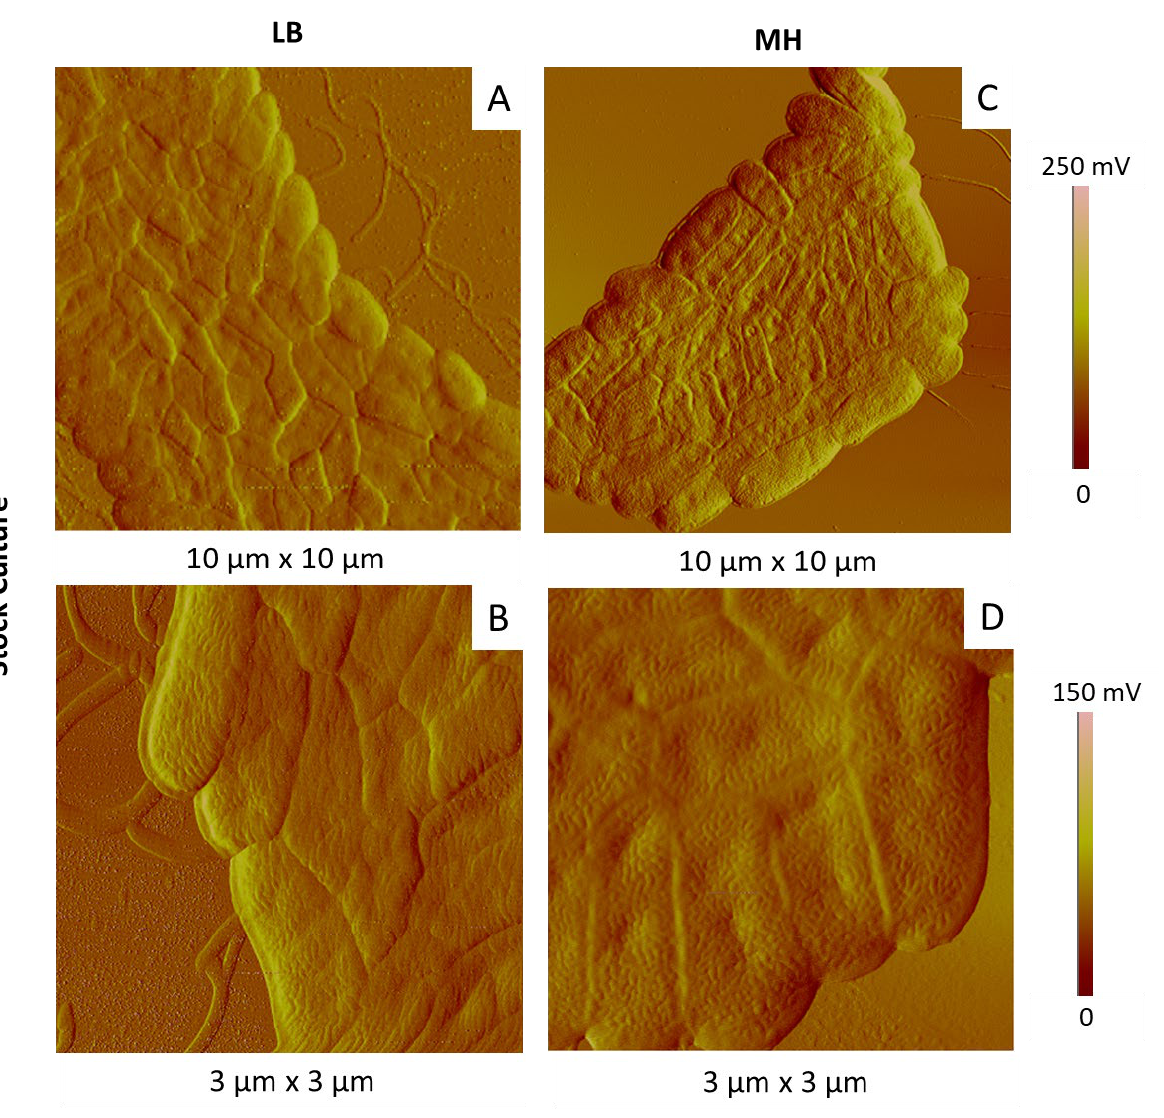
Figure 8. AFM amplitude images of P. fluorescens bacteria of first generation deposited by simple deposition from a culture in LB ( A , B ) and MH ( C , D ) media (15 h, 28 °C).